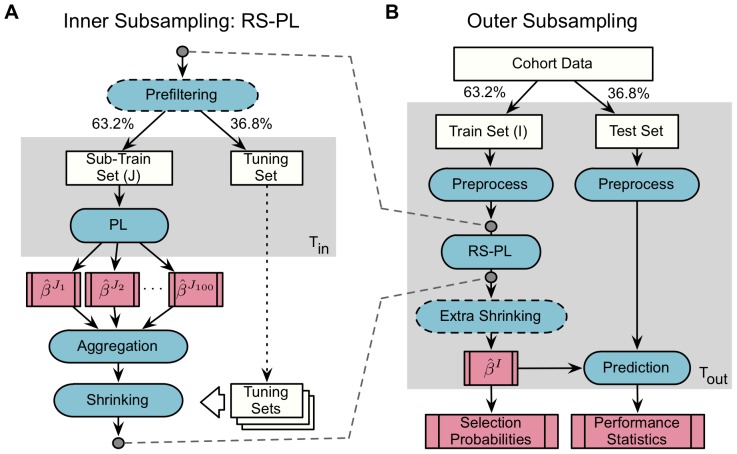
An overview of the suggested framework.Panel A: our core algorithm (abbreviated as RS-PL) performs robust selection with an inner subsampling, using the preconditioned lasso (PL) method inside. Potentially unstable model coefficient vectors  are aggregated and then shrunken to produce a robust model vector . Panel B: an outer subsampling is used to evaluate the prediction performance of RS-PL and to estimate selection probabilities of features. The ratios (63.2%∶36.8%) are chosen to resemble the effective sampling ratios in bootstrapping.